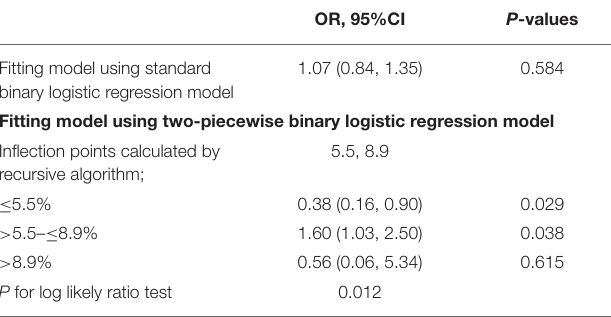
found that the trend of the OR among different GHB groups was non-equidistant. This non-equidistant variation of OR values indicates the possibility of nonlinearity.